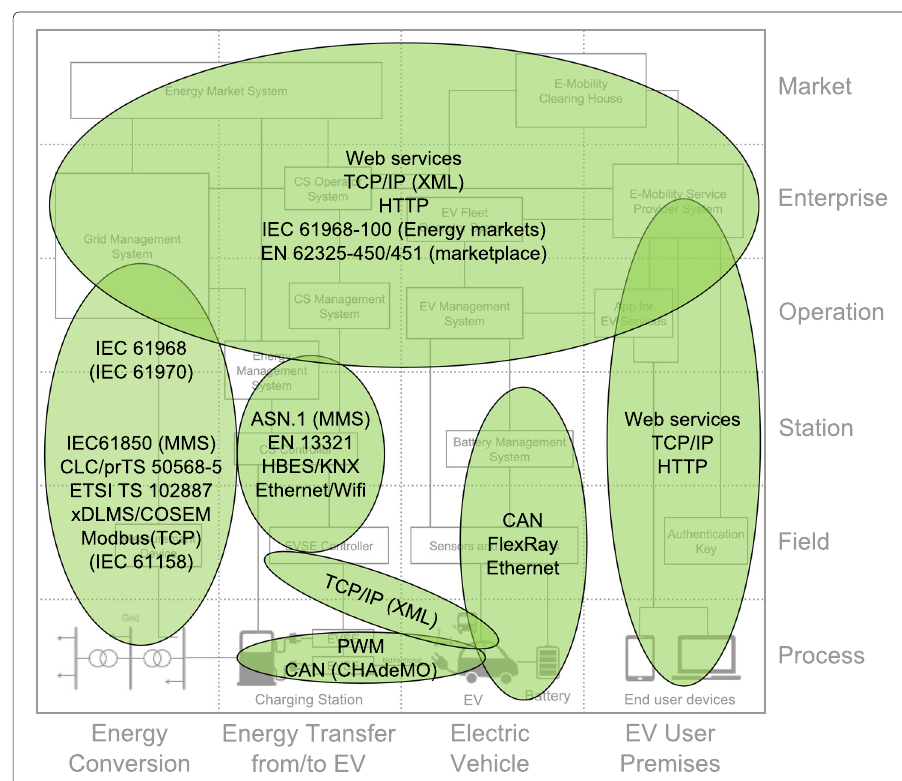
Fig. 8 EMSA communication layer with protocols. Compiled from CEN-CENELEC (2015); ElaadNL (2017); Rodríguez et al. (2015)